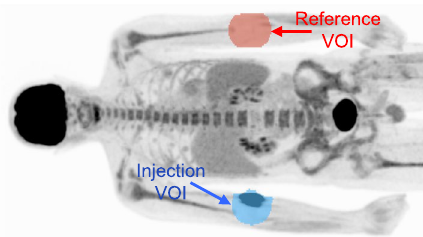
Fig. 2 Representative VOI placement for the PET-based extravasation activity estimation method. VOIs were placed on the injection and contralateral arms, “Injection VOI” and “Reference VOI,”